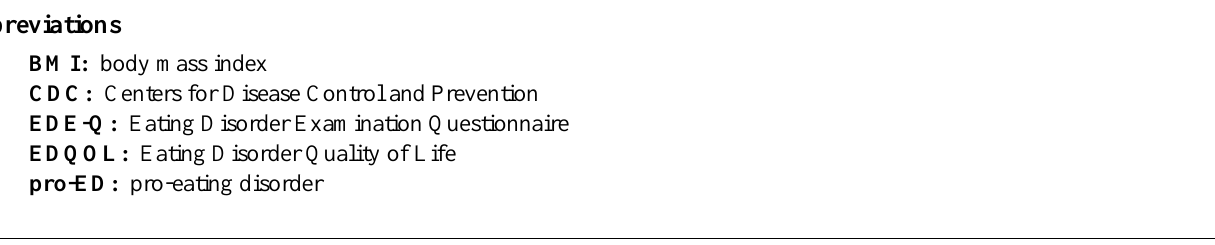
CDC: Centers for Disease Control and